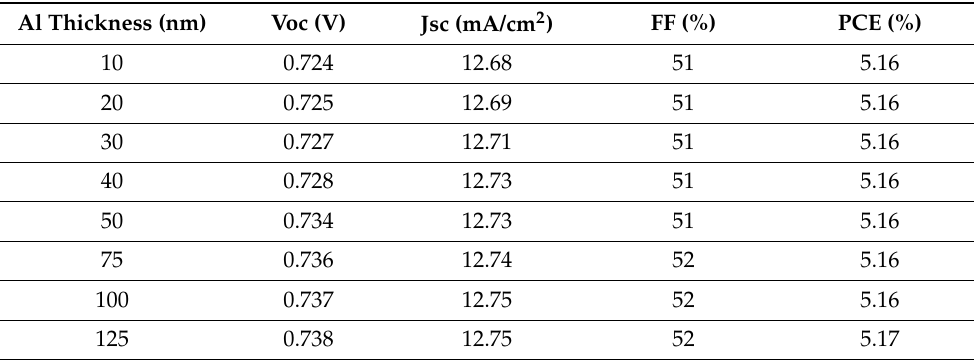
Table 2. Simulation results for different cathode layer